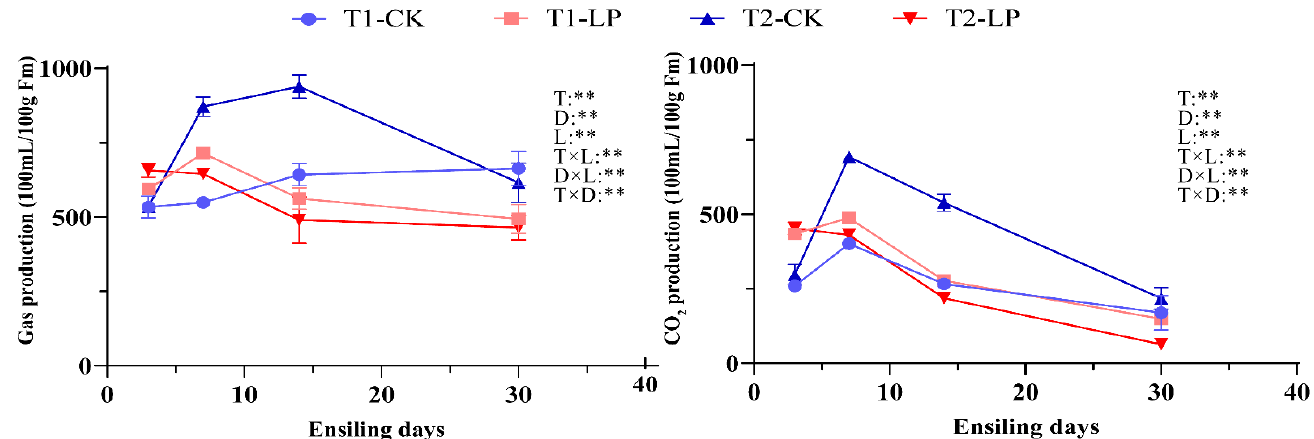
Figure 4. CO2 production and gas production for B. papyrifera leaves silage treated with LP inoculant and stored at 15 °C (T1) and at 30 °C (T2) after fermentation for 3, 7, 14, and 30 days, respectively. CK, the control; LP, Lactobacillus plantarum; T, temperature; D, ensiling days; L, with or without LP inoculant; T × D, the interaction of temperature and ensiling days; T × L, the interaction of temperature and LP inoculant; D × L, the interaction of ensiling days and LP inoculant. **, a significant difference ( P < 0.01).